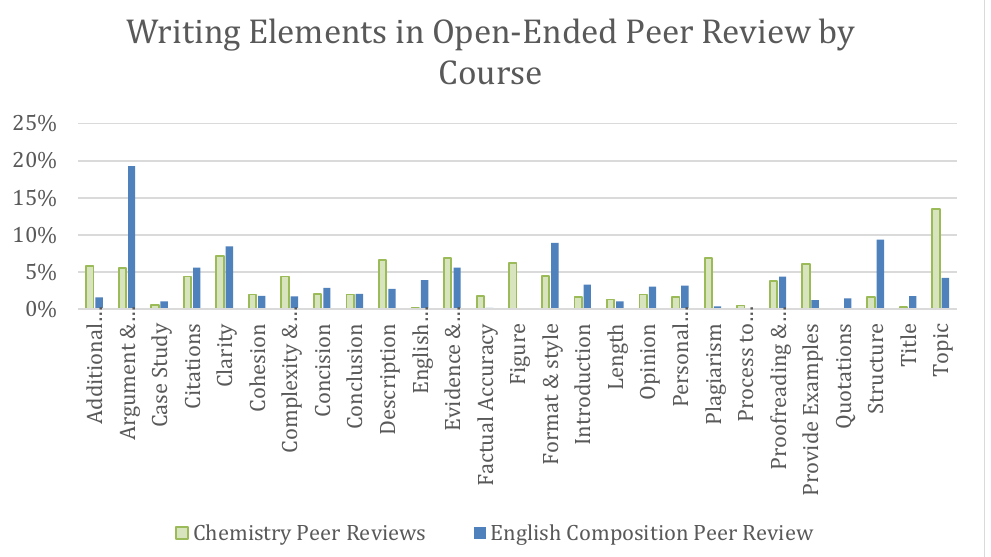
Figure 5 . Writing elements in open-ended peer review by